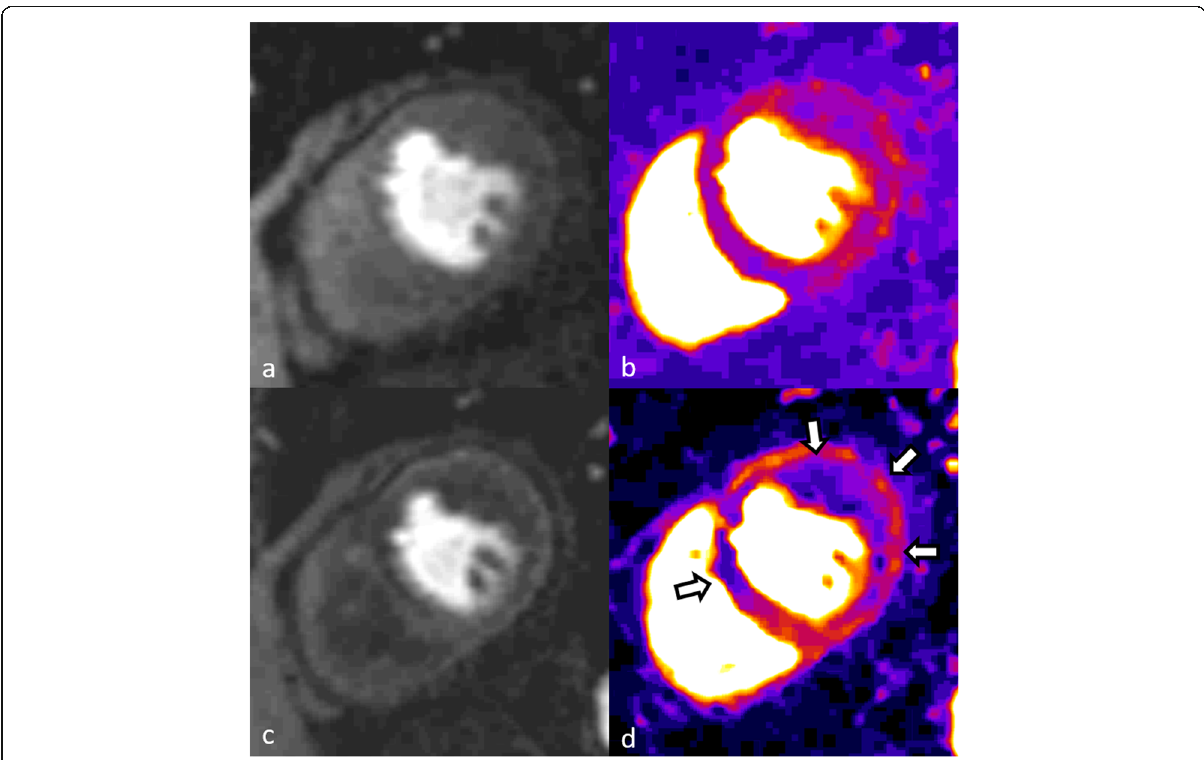
Fig. 3 First pass perfusion at rest ( a ) and stress ( c ) in a 58-year-old man with suspected coronary artery disease. Semiquantitative parametric slope maps ( b ) show no perfusion defects at rest, while extensive perfusion deficit (white arrows) in the anterior septum (left anterior descending area) and lateral wall (circumflex area) is demonstrated at stress ( d ), indicating transient ischemia likely due to left main